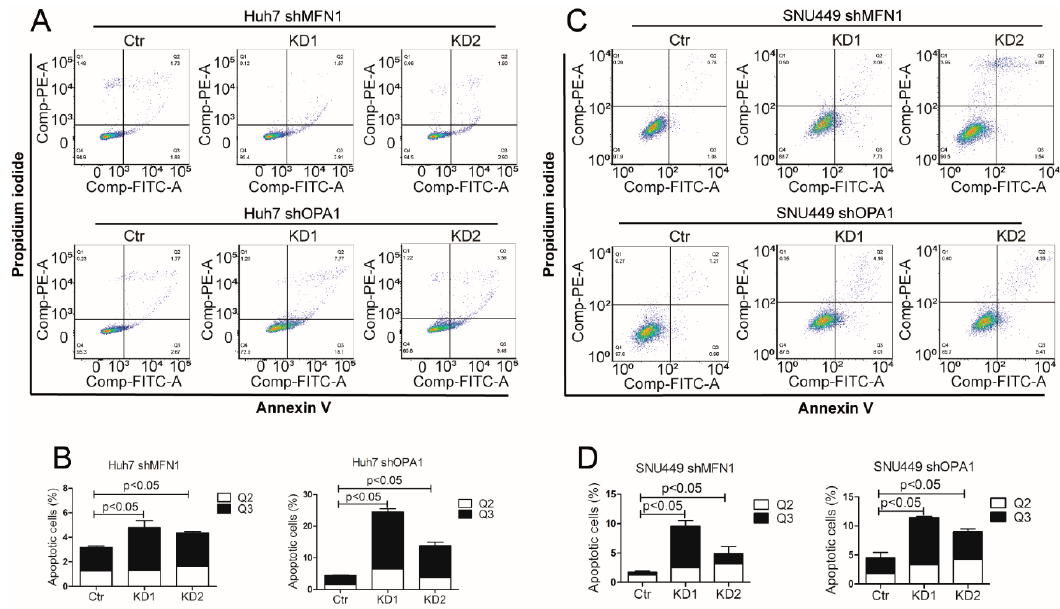
Figure 5. Mitochondrial fusion dysfunction inhibited tumor growth through cell apoptosis induction ( A , B ) Apoptotic cells were quantified by flow cytometry using Annexin V and propidium iodide co-staining in Huh7 shOPA1 and Huh7 shMFN1 cells (n = 3). ( C , D ) Apoptotic cells were quantified by flow cytometry using Annexin V and propidium iodide co-staining in SNU449 shOPA1 and SNU449 shMFN1 cells (n = 3). Histograms show means ± SEM with p value derived by the Mann Whitney test.